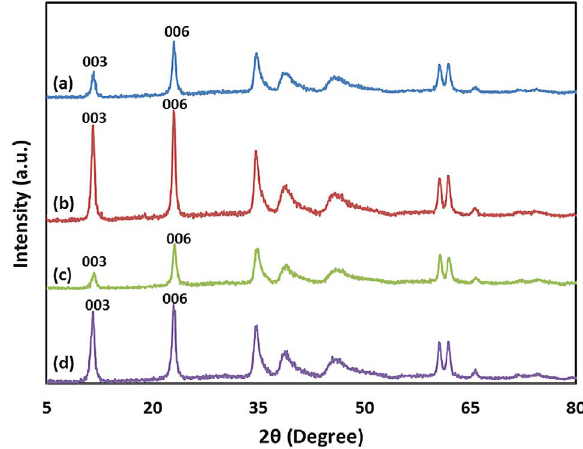
Figure 1. XRD spectra of (a) Mg-Al-LDH, (b) CR-adsorbed Mg-Al- LDH, (c) Mg-Al-LDH modified with NaOH solution at pH = 10 and (d) Mg-Al-LDH modified with NaOH solution at pH = 13.